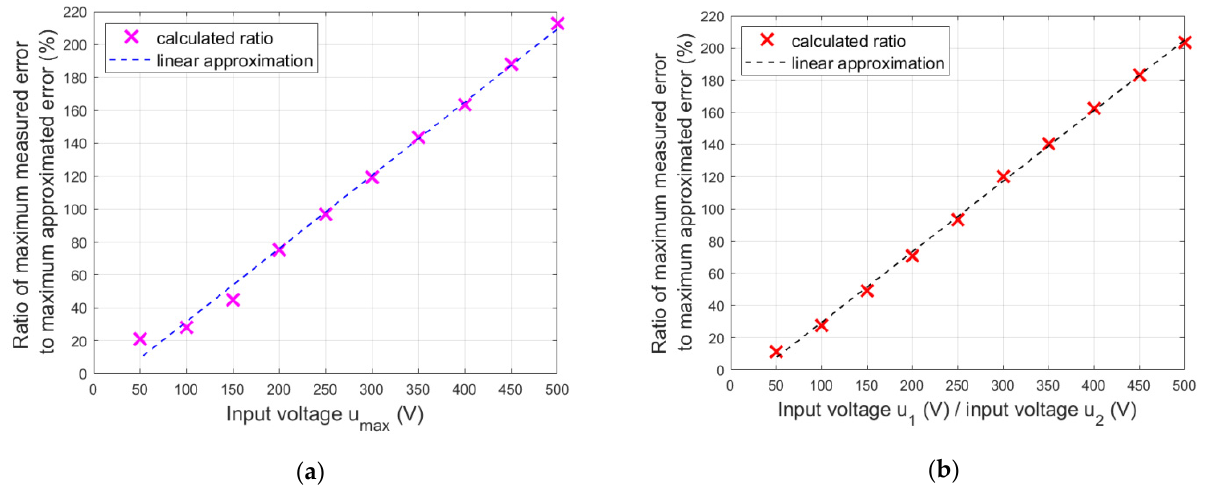
Figure 17. Ratios of the maximum measured error to the maximum approximated error vs. the maximum input voltages: ( a ) in the motion of the unimorph, ( b ) in the motion of the bimorph.